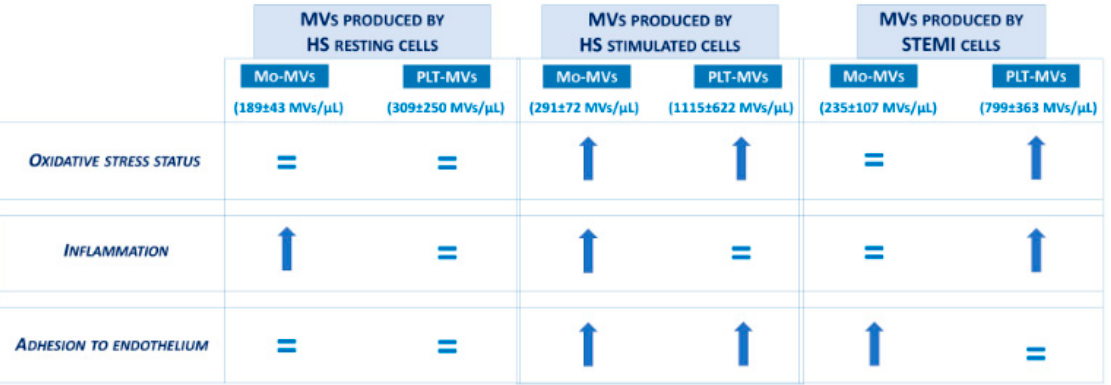
Figure 8. Summary of the endothelial effects exerted by MVs derived from healthy subject monocytes and platelets—under resting condition and upon stimulation—or spontaneously released by cells from STEMI patients.